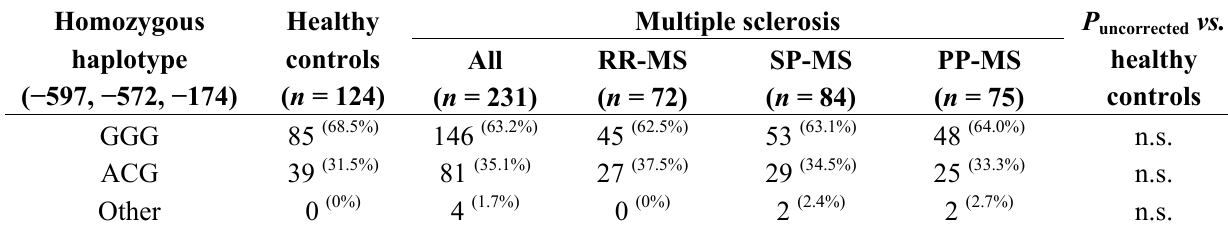
Table 3. Frequency of IL6 promoter region haplotypes, for those individuals who had identical haplotypes on each DNA strand.